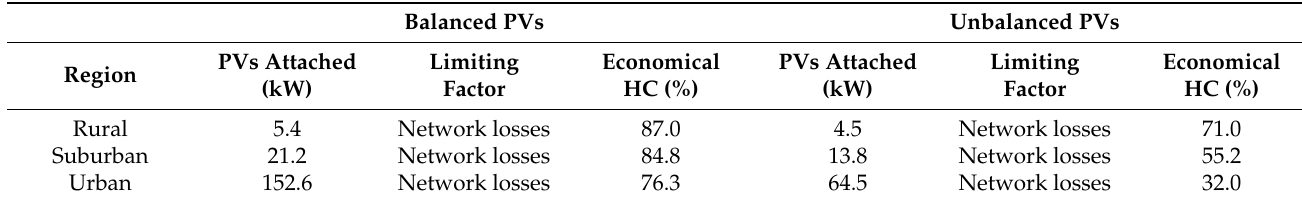
Table 7. Economical hosting capacity for three regions.